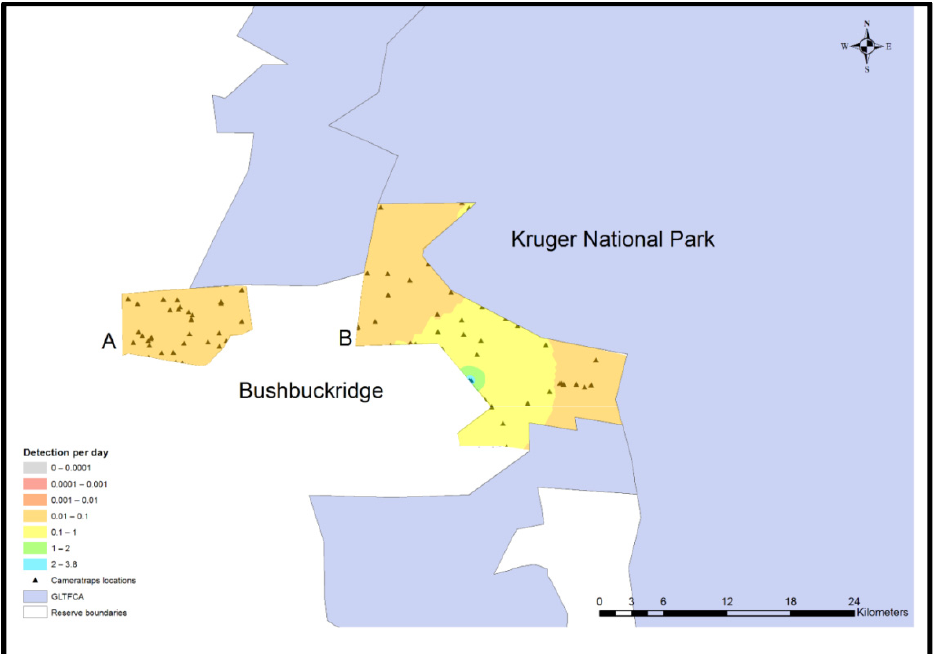
Figure 2. Any carnivore (lion, leopard, serval, civet, cheetah, jackal, wild dog, genet, mongoose, and spotted hyena) daily detection model for Andover ( A ) and Manyeleti ( B ) nature reserves adjacent to Bushbuckridge human settlements and Kruger National Park, Mpumalanga Province, South Africa, 2015–2017.